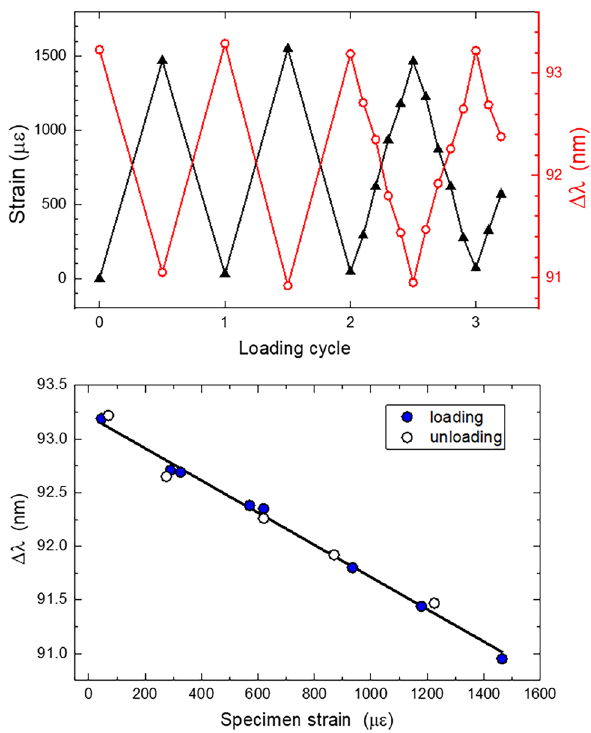
Figure 3. Top frame: recorded strain gauge readings (red) and averaged peak wavelength separations (black) under cyclic tensile loading; Bottom frame: peak wavelength separations vs. specimen strain for the final 1½ loading cycles (slope is − 1.5